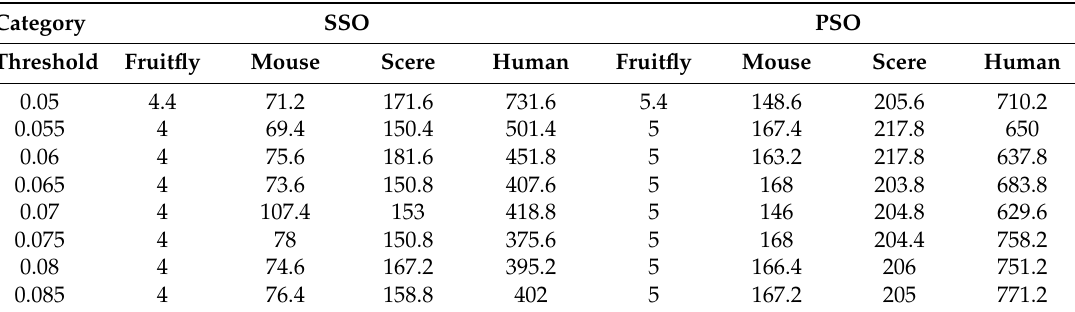
Table 4. The average running time